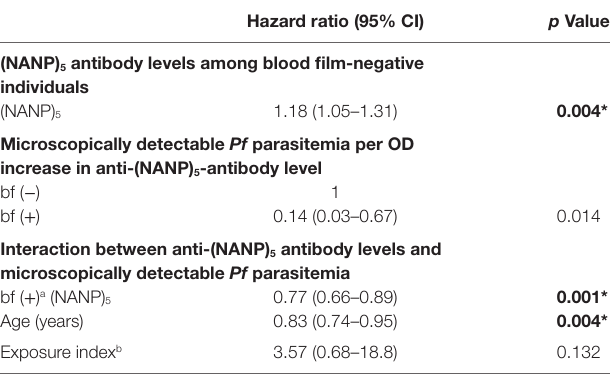
TaBle 2 | effect of interactions between anti-(nanP) 5 antibody levels and TaBle 1 | effect of interactions between anti- Pf spz antibody levels and microscopically detectable Pf parasitemia on the risk of clinical malaria. microscopically detectable Pf parasitemia on the risk of clinical malaria. hazard ratio (95%